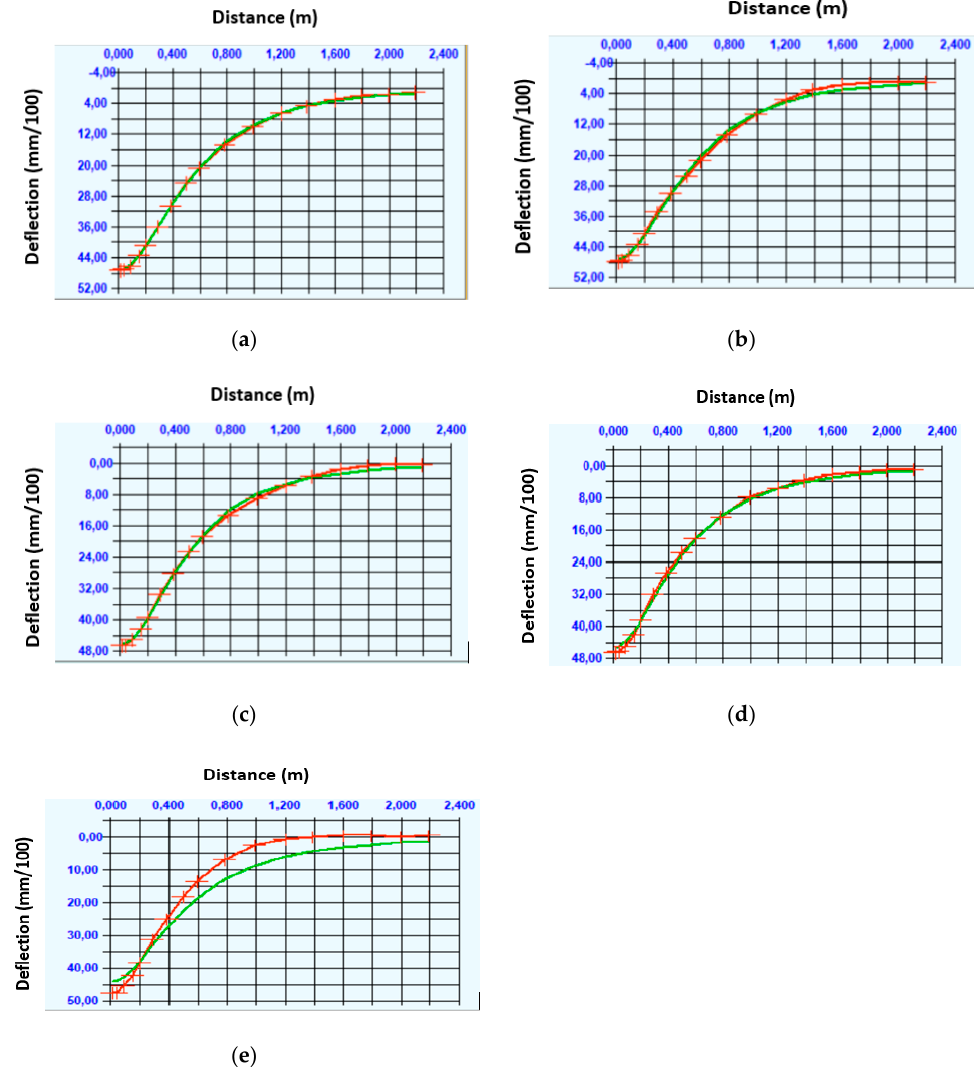
Figure 21. ( a ): Deflection fitting for Accelerometer CX Figure 21( b ): Deflection fitting for Accelerometer SD. ( c ): Deflection fitting for Geophones ION. ( d ): Deflection fitting for Geophones GS11D. ( e ): Deflection fitting for anchored deflectometer